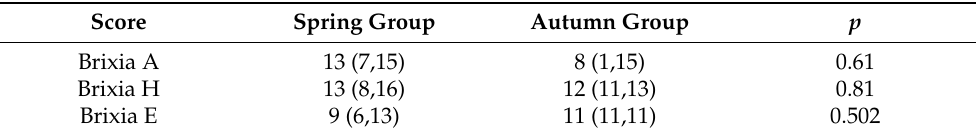
Table 2. Brixia scores in the two groups: median values and interquartile range.